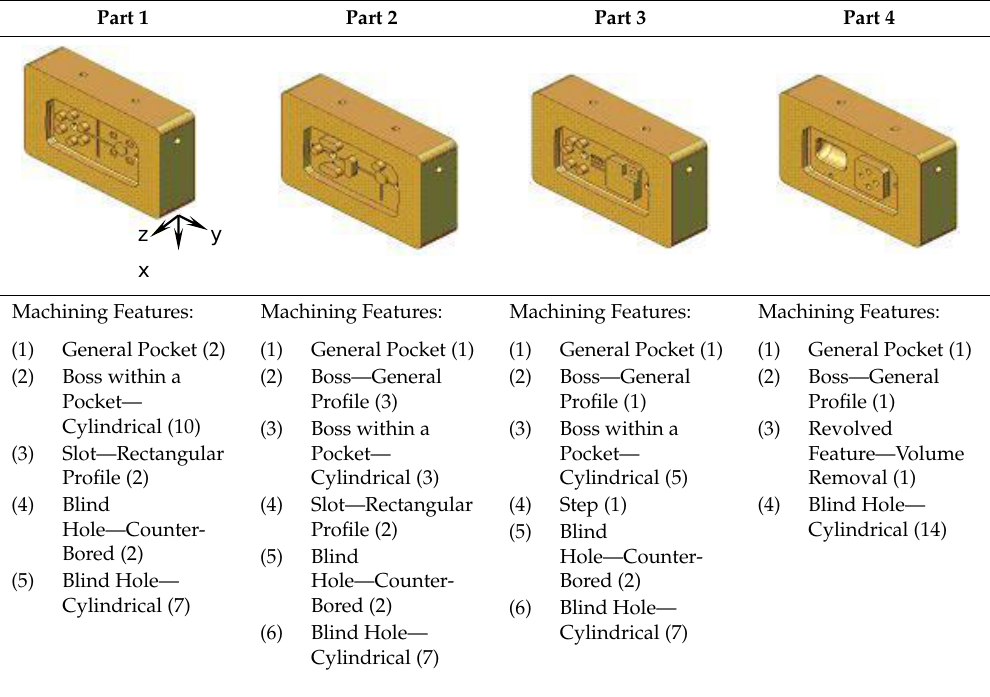
Table 2. Corresponding motion requirements.